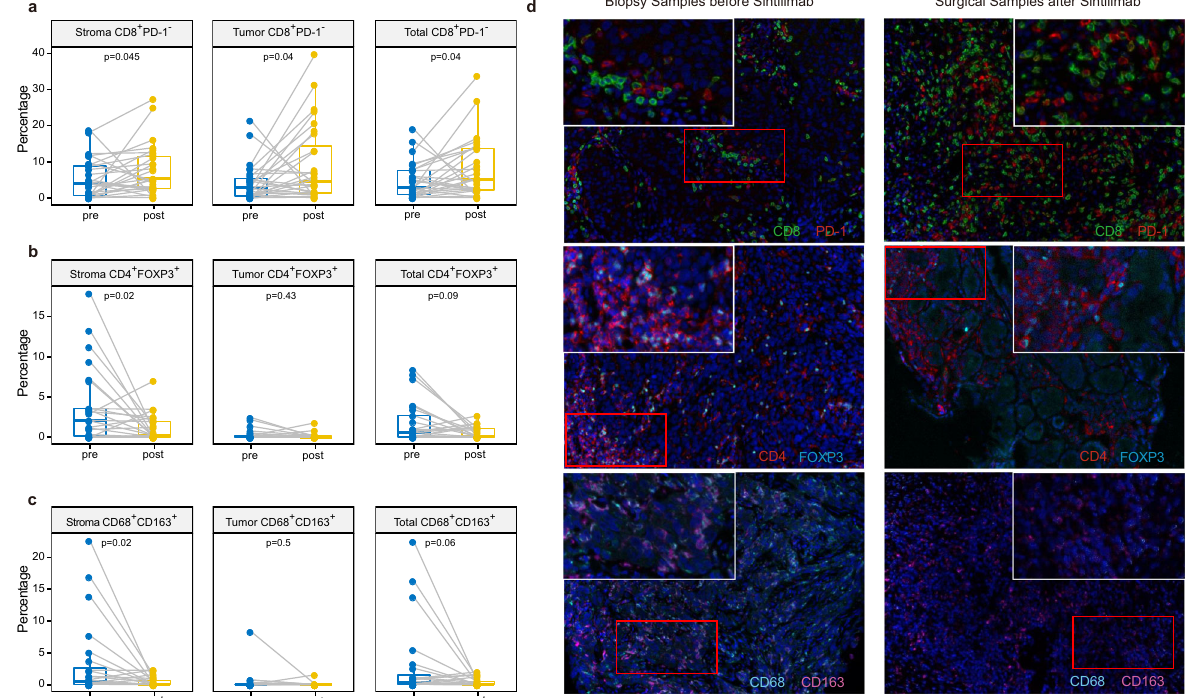
Fig. 4 Neoadjuvant anti-PD-1 blockade alters the immune cell in fi ltration in the tumor microenvironment. a – c Changes in the composition of indicated immune cells in fi ltration in stromal, tumor and total regions from pre- to post-immunotherapy samples (Mann – Whitney U test for paired samples). d Representative mIF staining fi gures of a patient with MPR depict the changes in presence of various immune cell types in response to sintilimab blockade. In the boxplots in this fi gure, the center line represents the median value, the bounds of the box represent the interquartile range, and the whiskers extend to 1.5× the interquartile range on either side of the